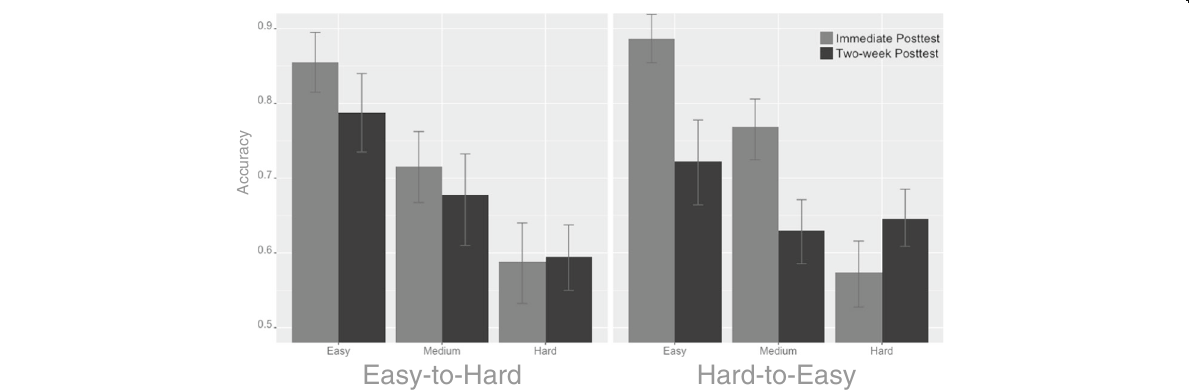
Fig. 8 The performance change in accuracy between immediate post-test and two-week post-test in easy, medium, and hard MDT items for participants receiving the easy-to-hard and hard-to-easy training. Error bars stand for 95% confidence